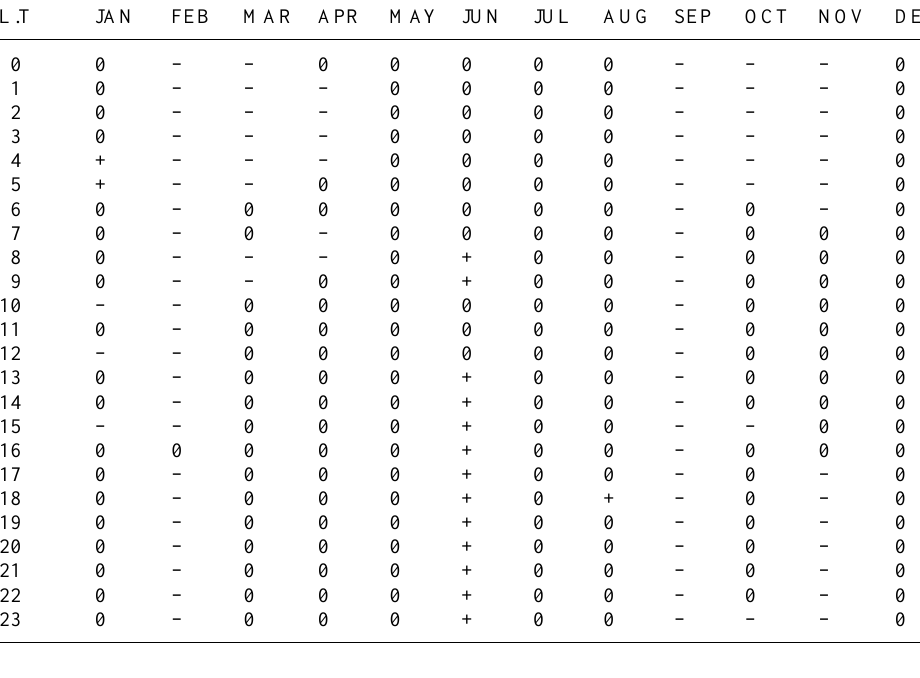
Table 2. Hours and months for which the coefficient a 2 of the quadratic term for fo F2 is significant in the case of positive, Slough data, +: a 2 negative, 0: a –: a 2 2